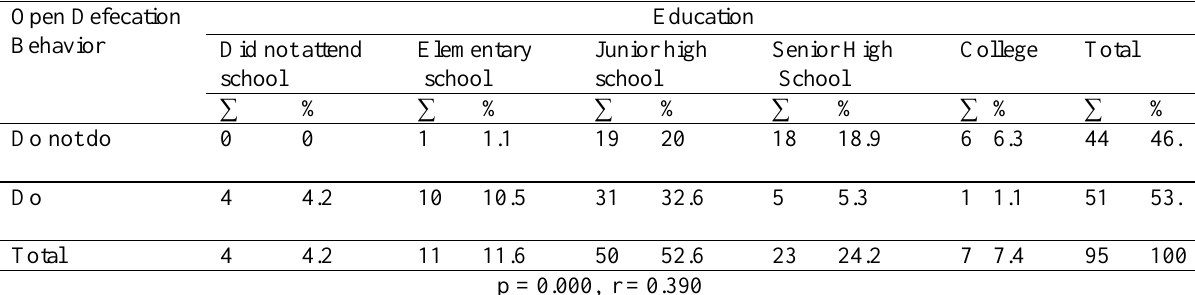
Table 1. The relationship between parent’s education and parent’s behavior about open defecation to school age children